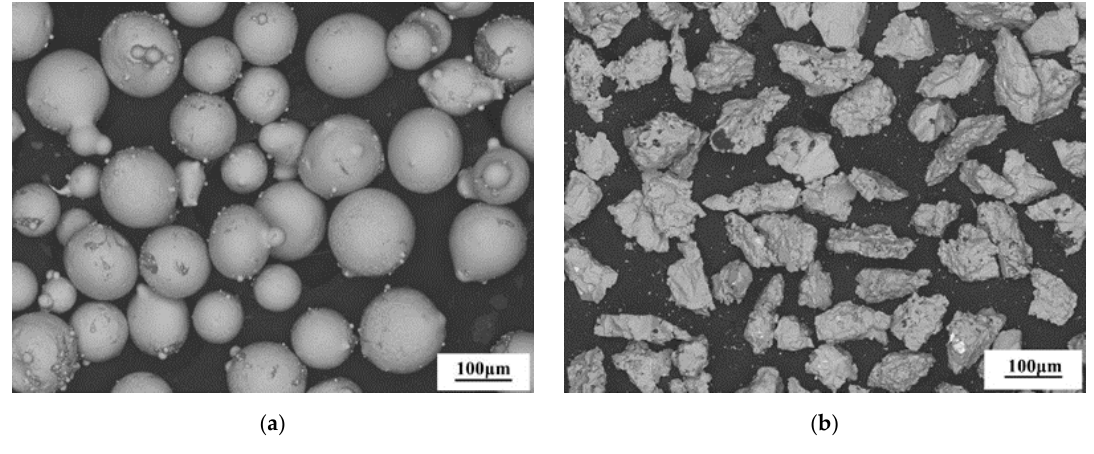
Figure 1. SEM image of cladding powder. ( a ) Ni35A; ( b ) TiC.